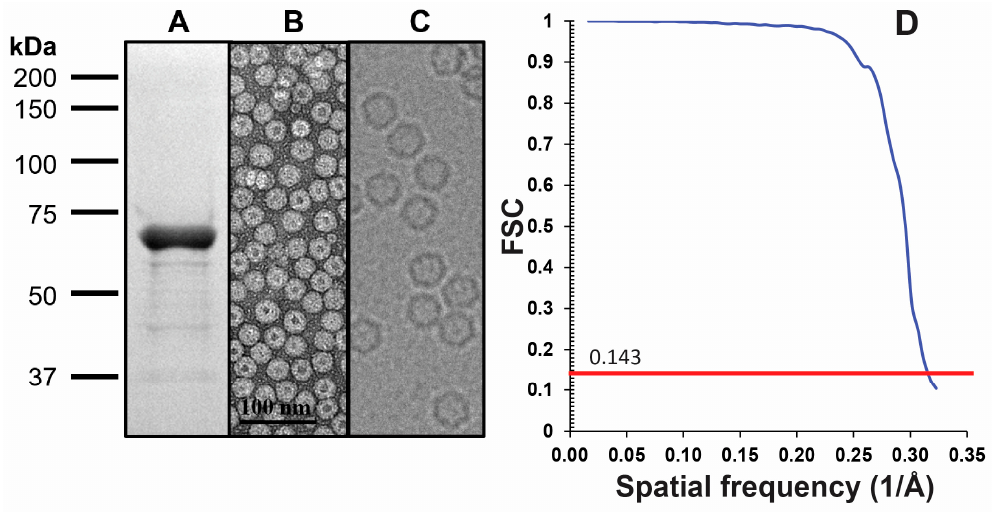
Figure 1. LuIII sample and data quality. ( A ) SDS-PAGE of purified VLPs. The VP2 is ~65 kDa in size; ( B ) negative stain EM of purified VLPs (42,000 × , Scale bar = 100 nm); ( C ) representative micrograph from cryo-EM data collection, not visualized to scale; ( D ) FSC plot for the final iteration of 3D map reconstruction (red line indicates the 0.143 threshold utilized to estimate resolution).